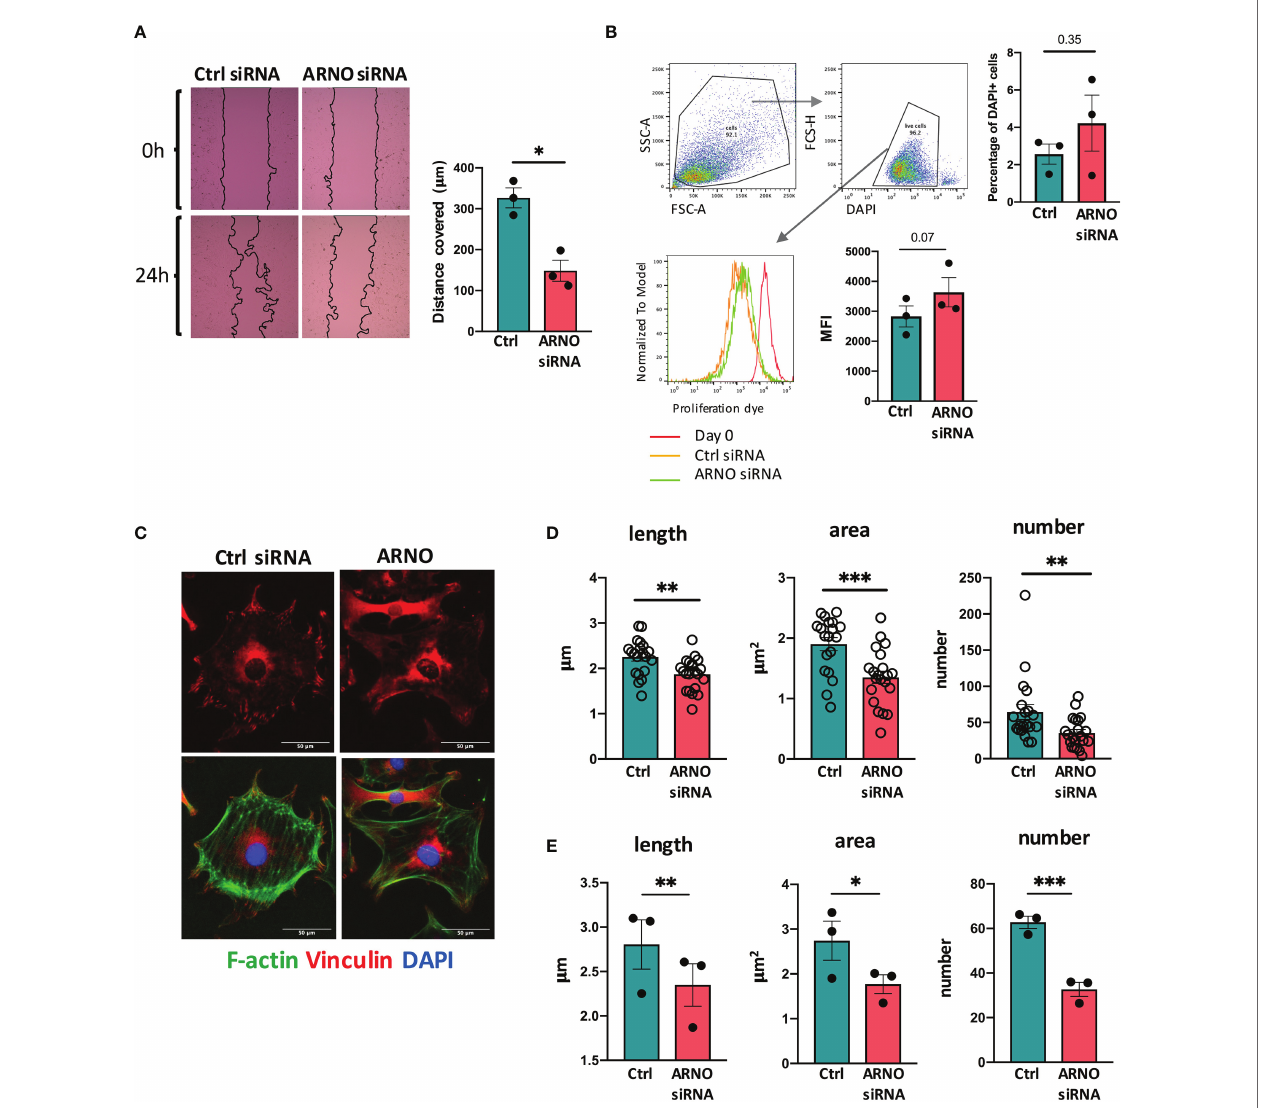
FIGURE 2 | ARNO regulates SFs migration and assembly of focal adhesions. (A) SFs were seeded in migration chambers and grown until monolayer con fl uence. Cells were then treated with either Allstars control or ARNO siRNAs, when inserts were removed to perform migration assays. Pictures show one representative experiment, superimposed black lines delineate the cell-free area. Bar chart shows the mean of cell migration distance ± SEM from three independent experiments calculated with ImageJ software. (B) SFs were labelled with proliferation dye eFluor 670 (eBioscience), analysed by fl ow cytometry (day 0) or treated with control or ARNO siRNA, when cells were maintained in culture. After 5 days, mean fl uorescence intensity was evaluated in live cells (identi fi ed by low DAPI staining). Histogram shows one representative experiment. Mean fl uorescence intensity (MFI) of three independent experiments is shown in the column graph, error bars represent ± SEM. (C) Representative immuno fl uorescence staining of Vinculin (red) and F-actin (green) in SFs treated with Allstars control or ARNO siRNA. Scale bar: 50um. (D) Number, length and area of vinculin positive areas were analysed with ImageJ in SFs treated with Allstars control or ARNO siRNA. Each dot represents one single cell, data are from one representative experiment. (E) Mean of number, length and area of vinculin positive areas from three independent experiments, in SFs treated with Allstars control or ARNO siRNA. Error bars error bars represent ± SEM. *p < 0.05, **p < 0.01, ***p < 0.001 by Mann-Whitney